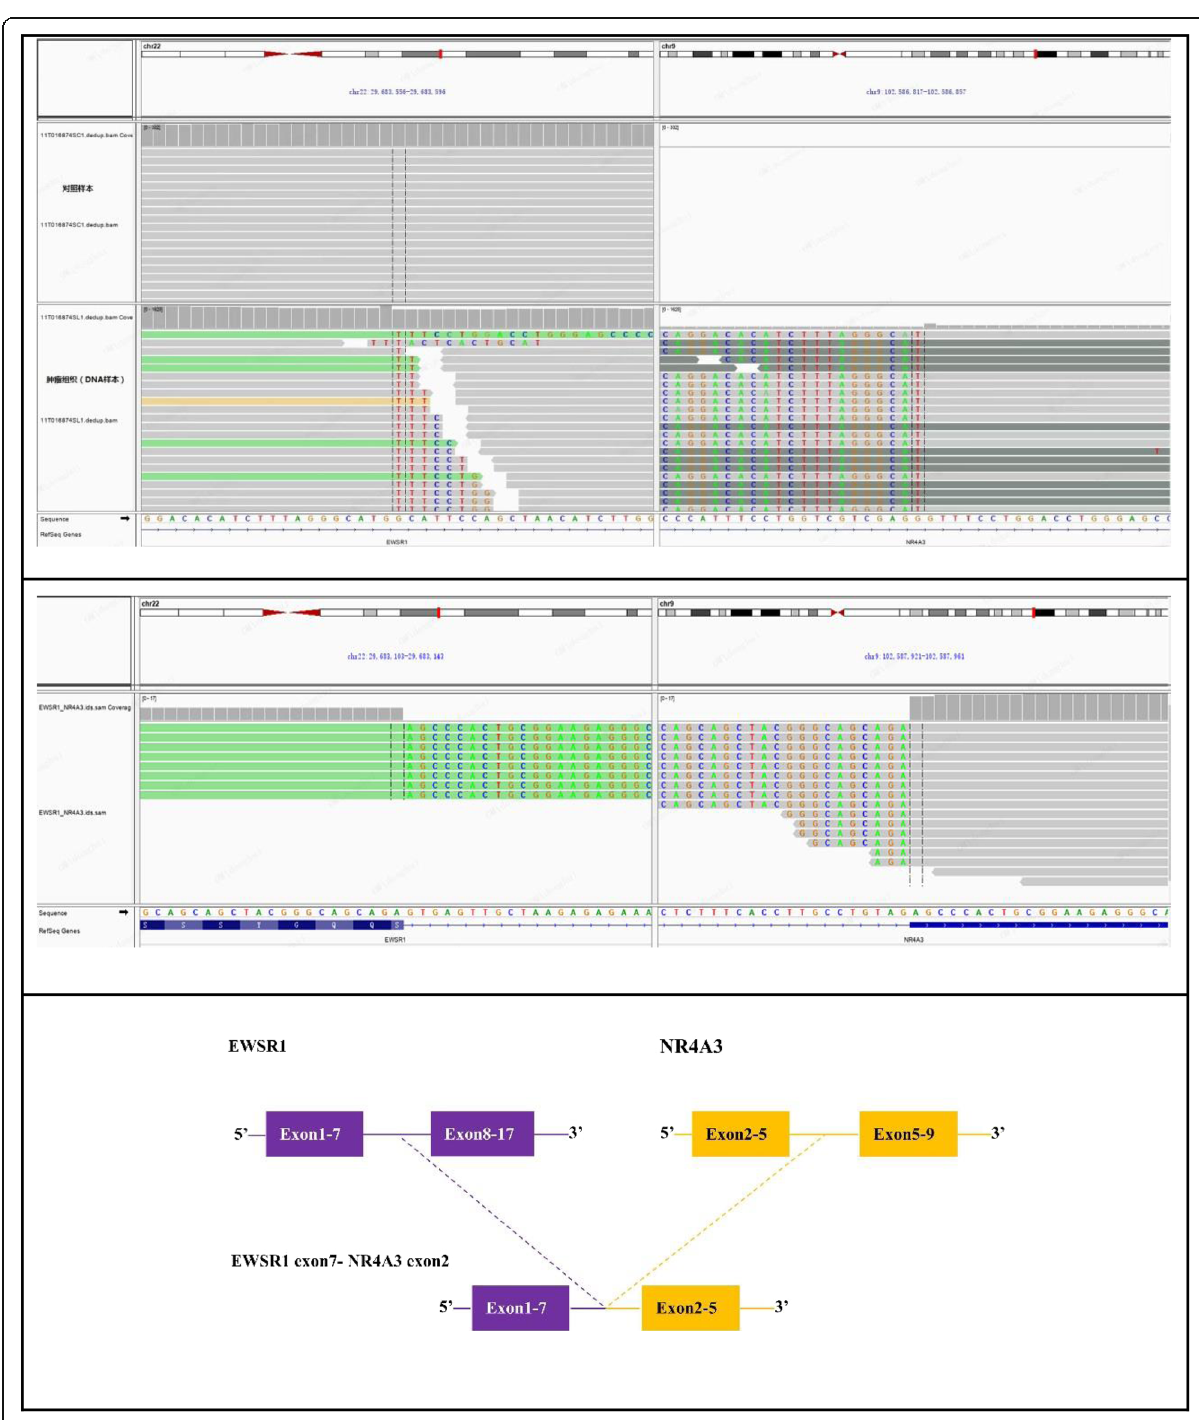
Fig. 4 NGS revealed the EWSR1-NR4A3 fusion was identified by DNA next-generation sequencing (above) and RNA next-generation sequencing